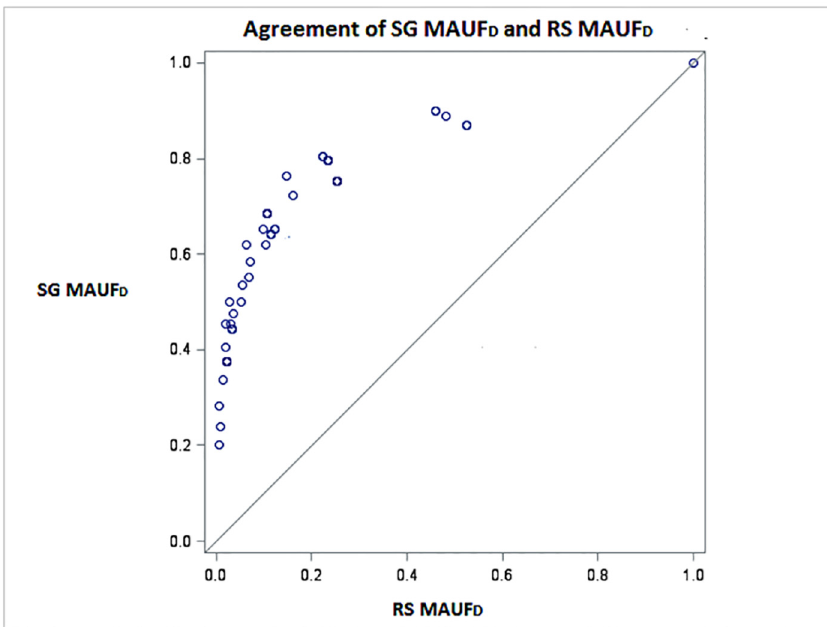
Fig 4. Scatter plot to assess agreement between the SG MAUF D and the RS MAUF D for the development sample.